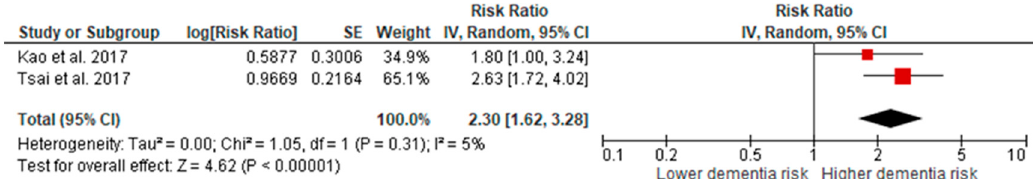
Figure 3. Risk of dementia in AKI patients with one year increase in age .